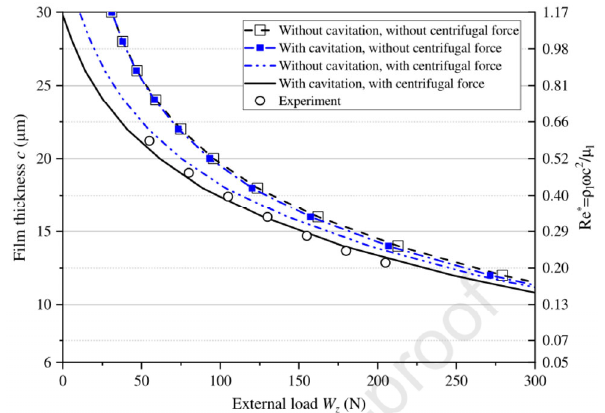
Fig. 57 Film thickness curve comparison between the model calculation and experiments [863]. Reproduced with permission from Ref. [863], © Elsevier Ltd.,